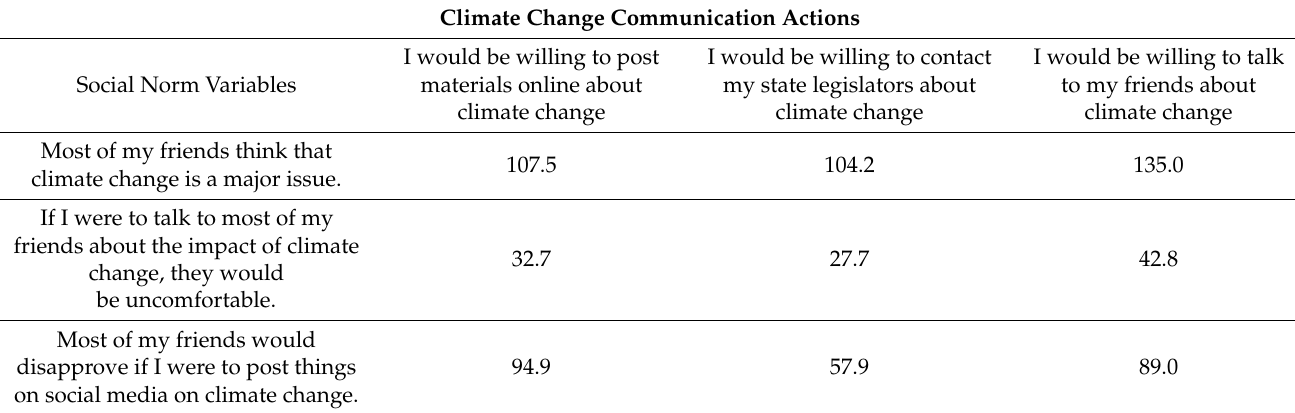
Table 3. Chi-square statistics values for the associations between climate change communication actions and social norms (N = 586) 1